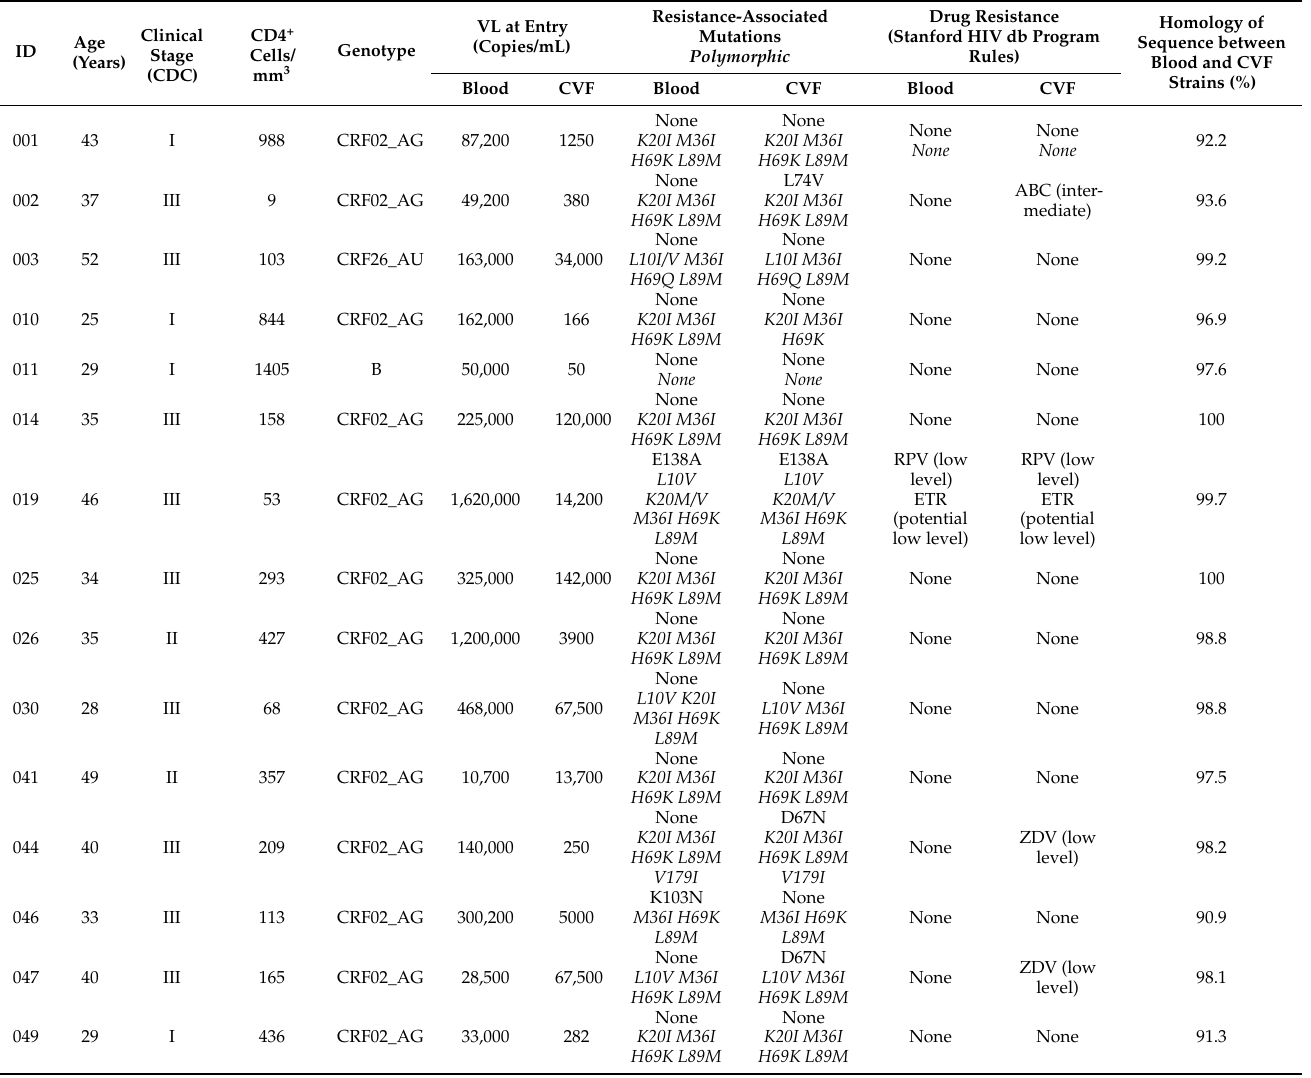
Table 1. Paired resistance genotyping profiles successfully obtained in blood and CVF samples from 24 females before initiation of